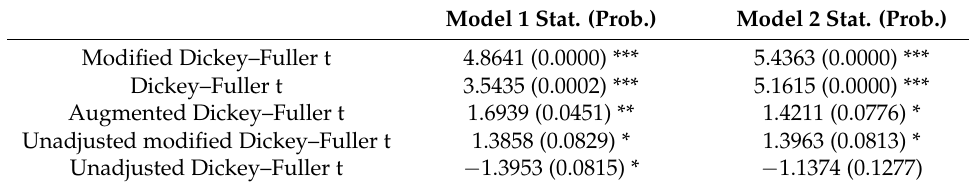
Table 5. Co-integration test based on the Kao test.